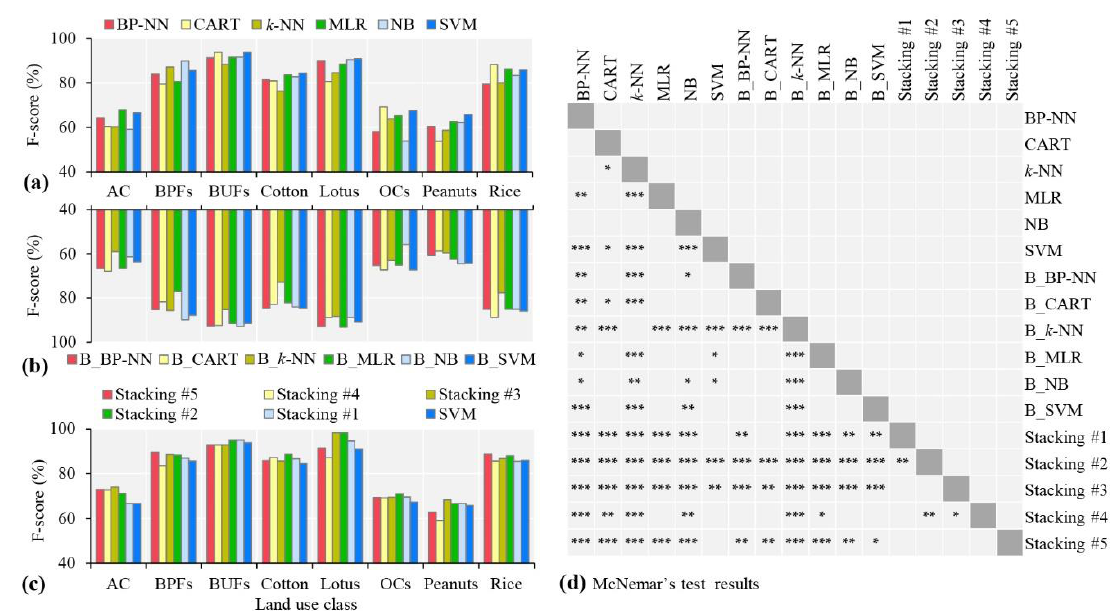
Figure 5. Classwise F-scores were obtained using the individual classifiers ( a ) and the bagging ( b ) and stacking models ( c ). Statistical significance of the differences in accuracy between the pairs of models ( d ). *, **, *** represent p -values of 0.05 < p < 0.1, 0.01 < p < 0.05, and p < 0.01, respectively, according to McNemar’s test. AC, abandoned cropland; BPFs, bare paddy fields; BUFs, bare upland fields; OCs, other crops. Table 3. Overall accuracies, kappa values, and weighted-average F-scores of the six classifiers.